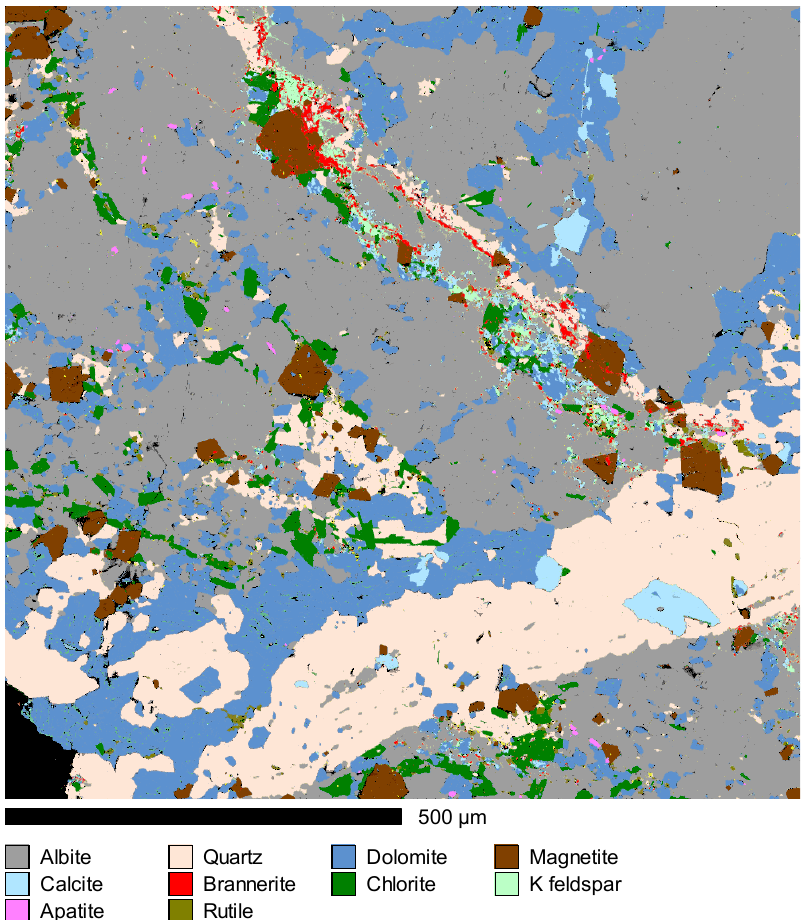
Figure 8. Phase patched map of sample from Valhalla drillhole VRD0126.